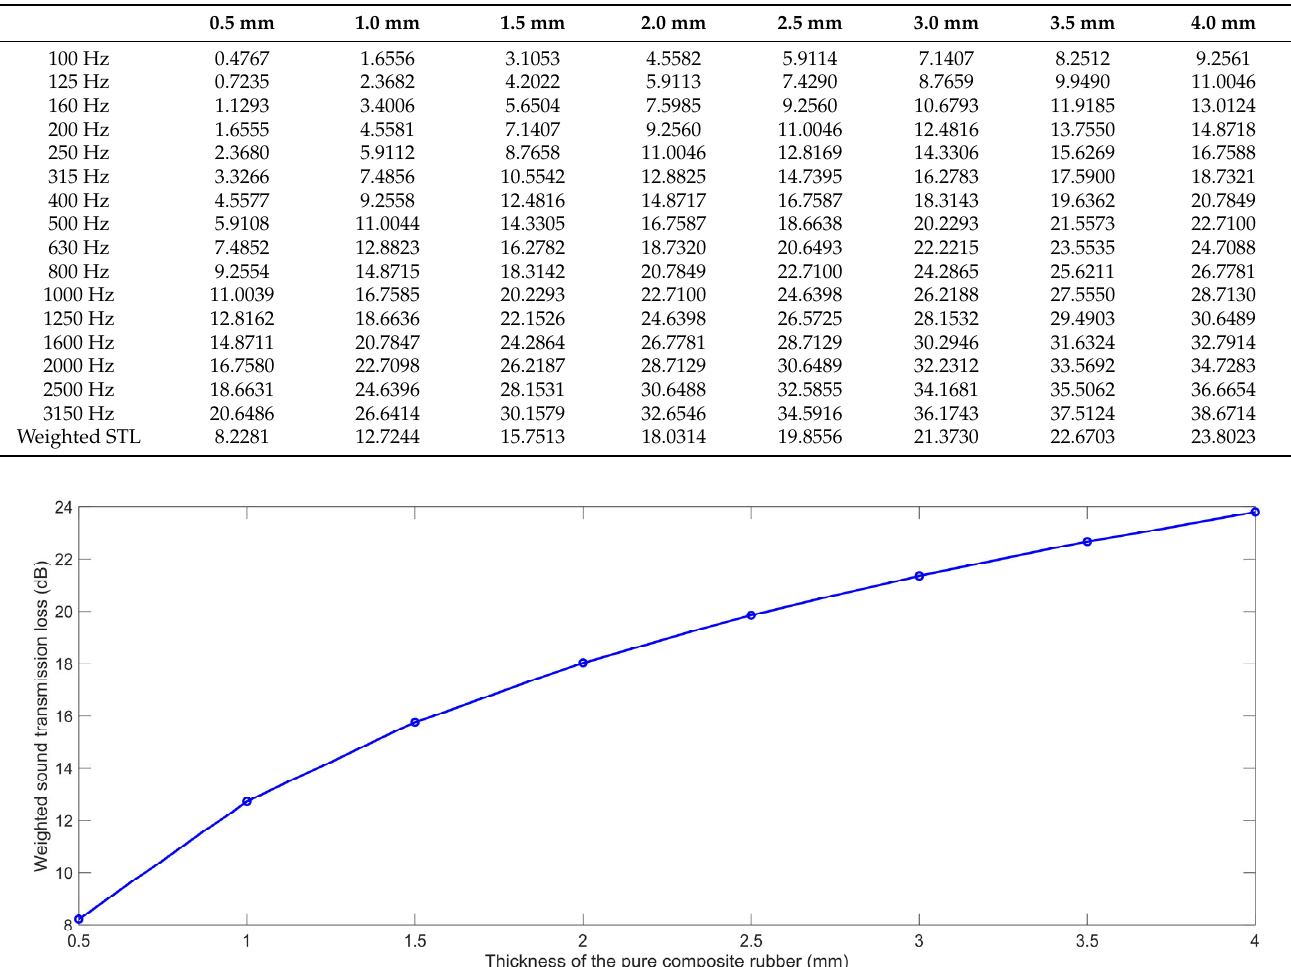
Figure 18. The weighted STL of the pure composite rubber with the various thickness.